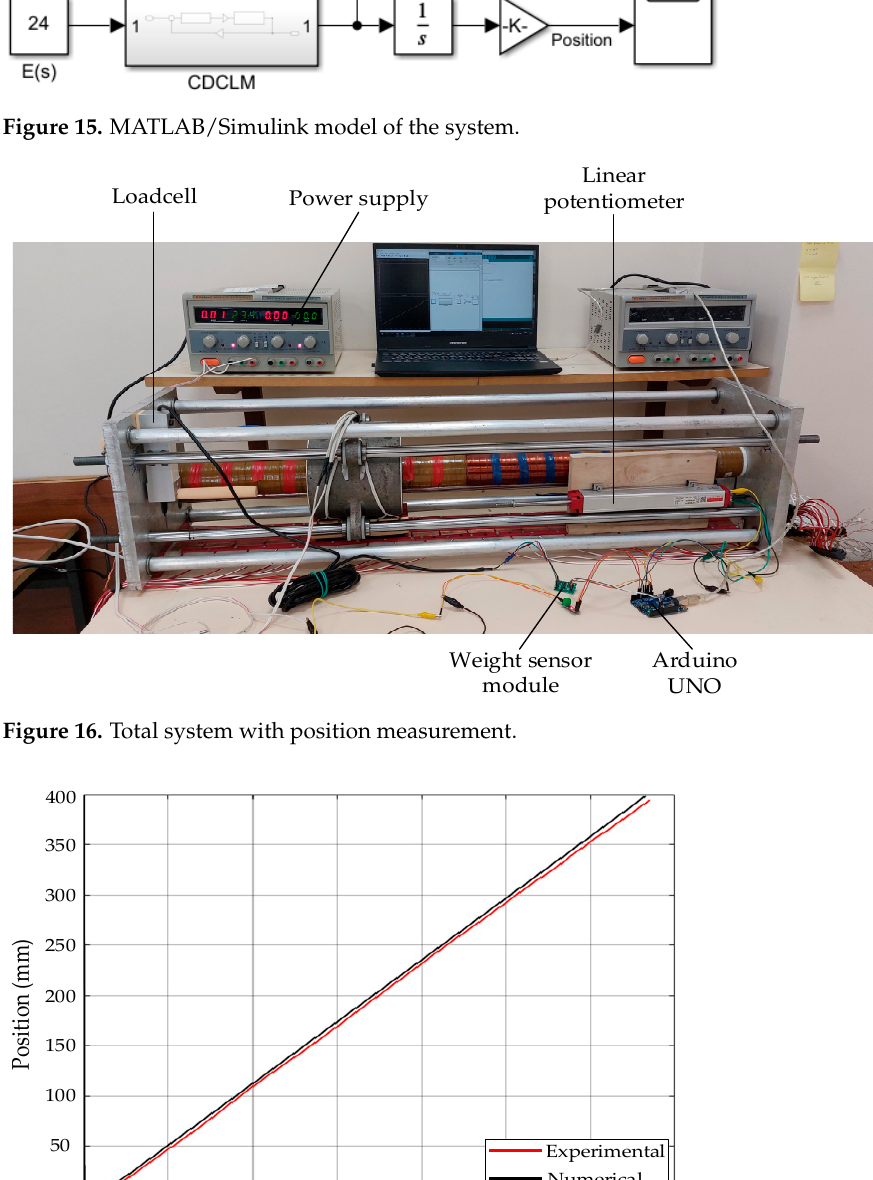
Experimental Numerical Figure 18. Time variations of velocities for simulation and experiment.